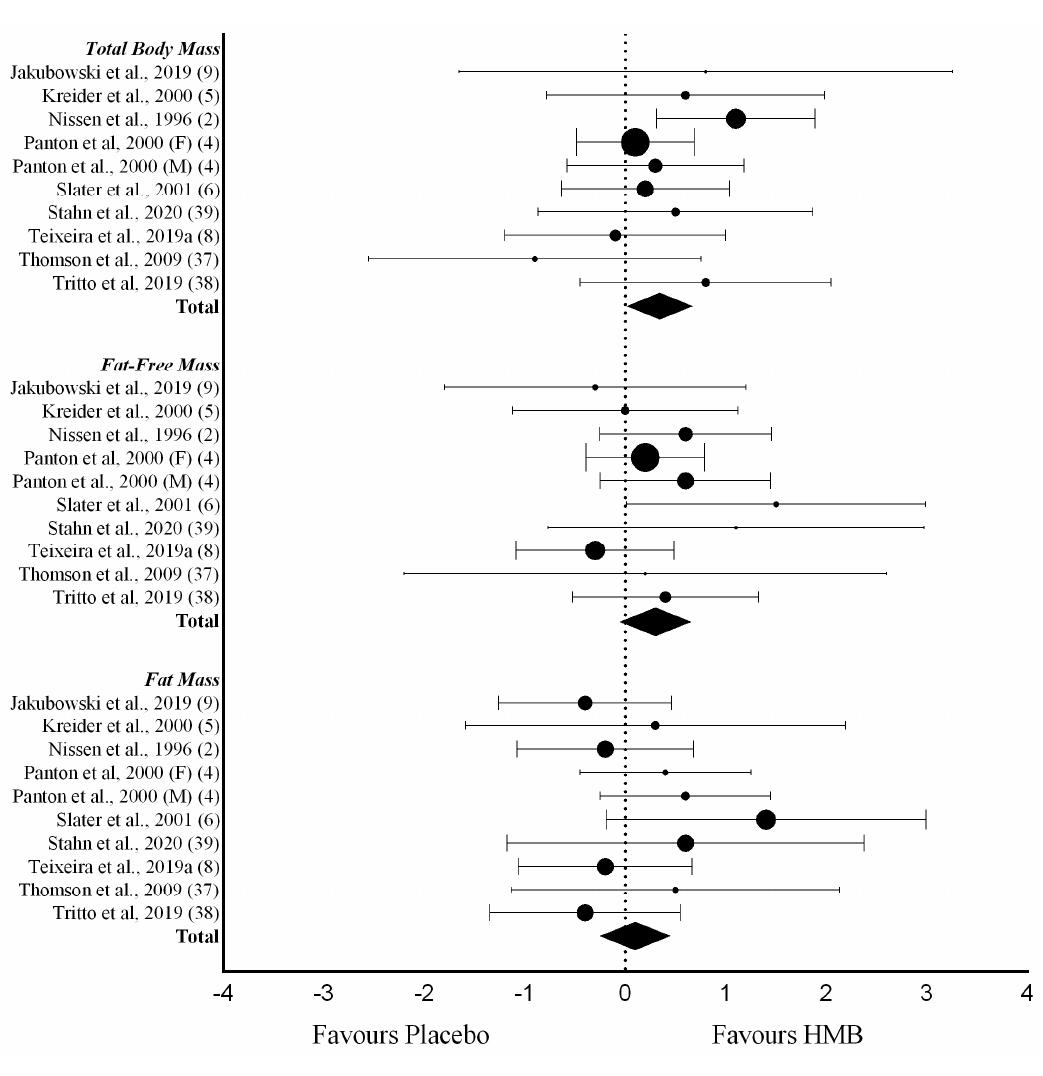
Figure 2. Forest plot of a random-e ff ects meta-analysis for the e ff ect of HMB supplementation on changes in TBM (9 studies, 10 trials), lean body mass (9 studies, 10 trials) and fat mass (10 studies, 9 trials). Results are presented as mean di ff erence between HMB supplemented (Experimental) and Placebo group with 95% CIs. HMB, β -hydroxy- β -methylbutyrate; CIs, Confidence